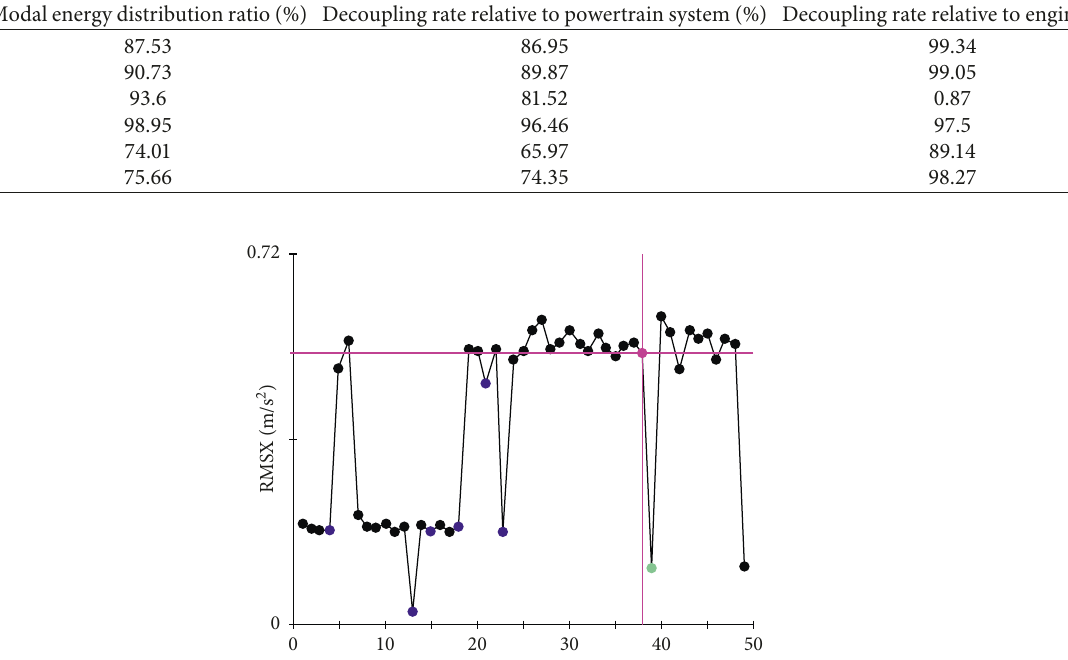
Table 1: Decoupling rate distribution in all directions.